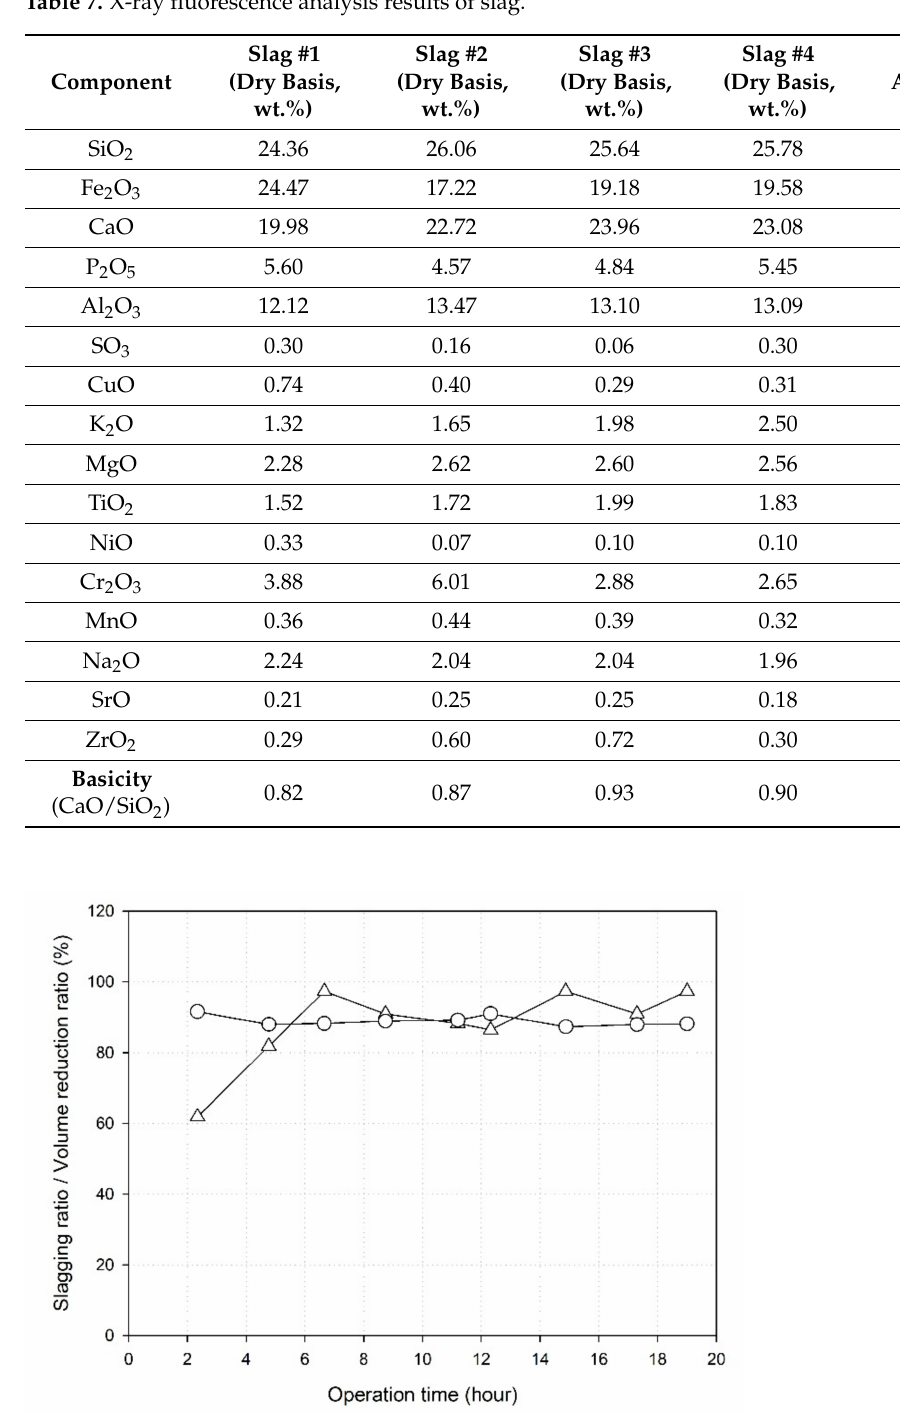
Figure 13. Results of slagging and volume reduction ratio ( (cid:52) : Slagging Ratio, reduction